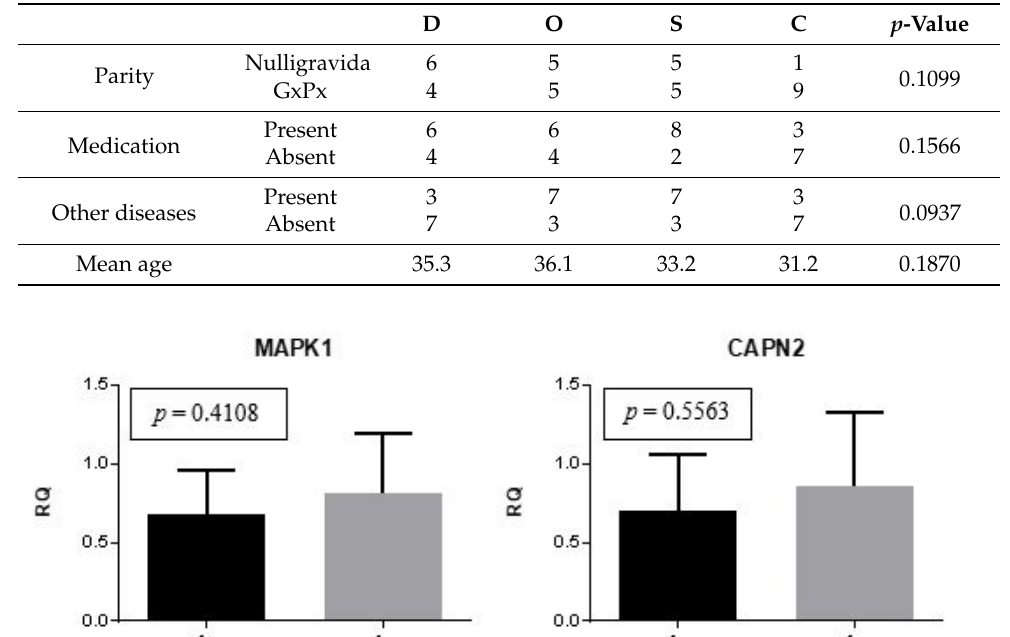
Table 1. Demographic variables of the analyzed patients. The chi-squared test was used for qualitative variables. D: deep infiltrating endometriosis; O: ovarian endometrioma; S: superficial peritoneal endometriosis; and C: control.